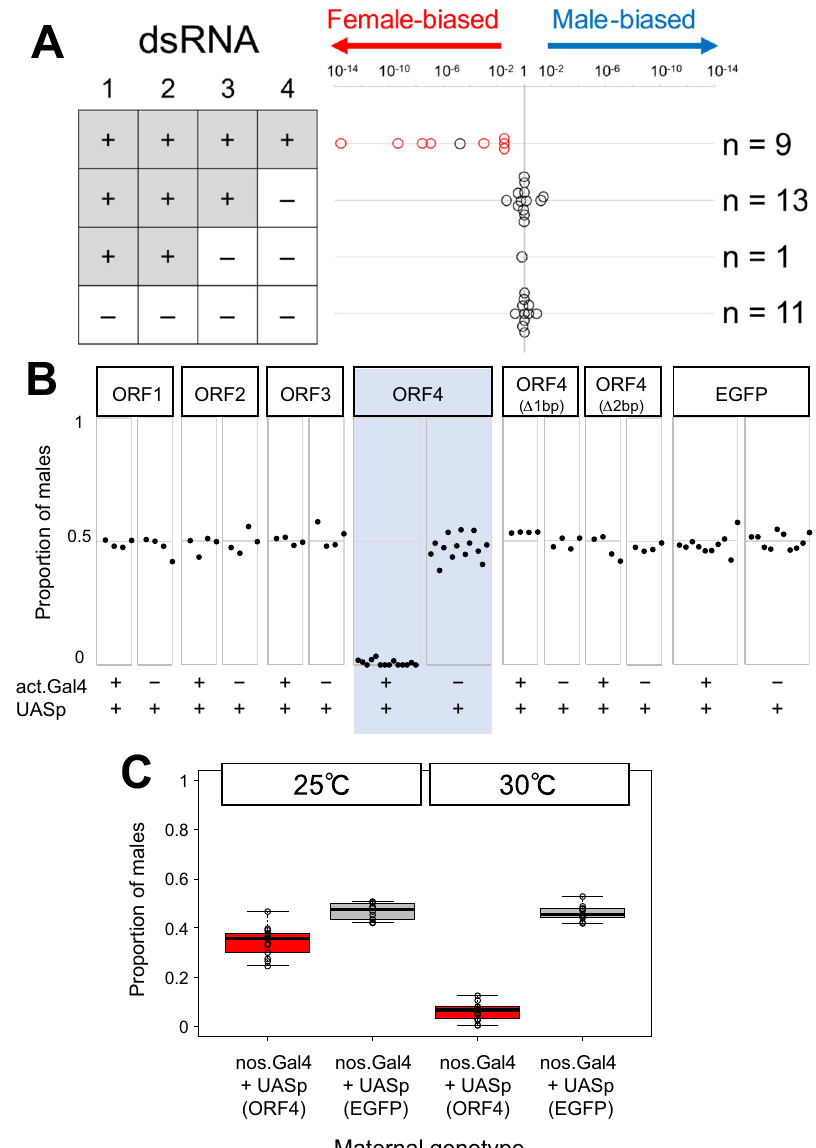
Fig.3|FunctionalcharacterizationofthefourORFs.A Offspringsexratiosof34 broods associated with the presence/absence of the four RNA fragments (dsRNA1 – dsRNA4) in their mothers resulting from the transinfection of DbMKPV1 in Drosophila biauraria . B ORF overexpression effects on sex ratio in Drosophila melanogaster (using actin ubiquitous driver). ORF1, ORF2, ORF3, ORF4, two fra- meshifted ORF4, and EGFP were ectopically expressed. Male proportion among emerged adults is shown. C Effects of maternal expression of ORF4 using nanos